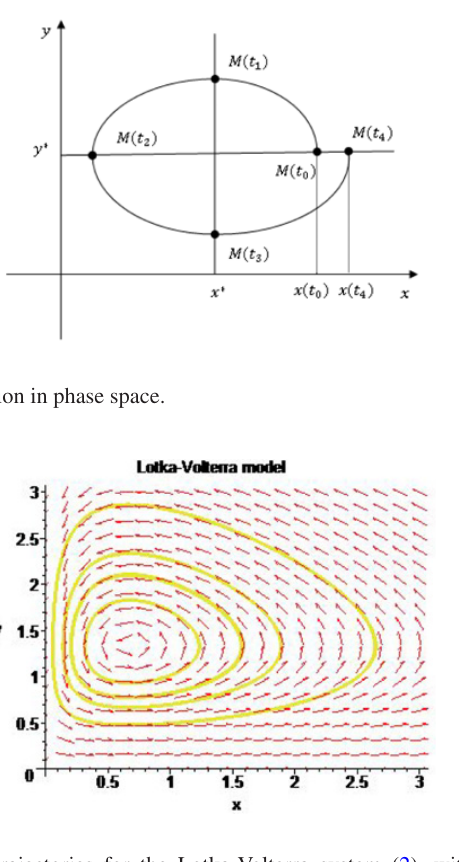
Figure 3. Closed phase plane trajectories for the Lotka-Volterra system (2), with a = 0.8, b = 0.6, (cid:1) = 0.5, d = 0.2, h =